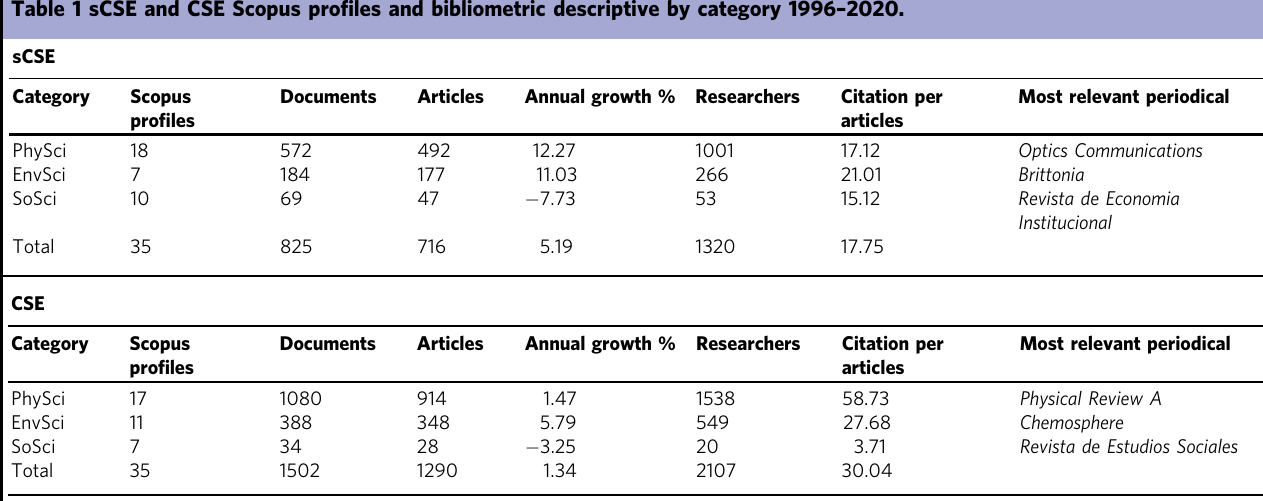
Fig. 2 sCSE and CSE sample by ASJC subject. Source: (Fundación Alejandro Ángel Escobar, 2020; Scopus, 2021; Fundación Alejandro Ángel Escobar 2007; Aria and Cuccurullo 2017; Scopus 2020a; Minciencias 2021). Table 1 sCSE and CSE Scopus pro fi les and bibliometric descriptive by category 1996 –